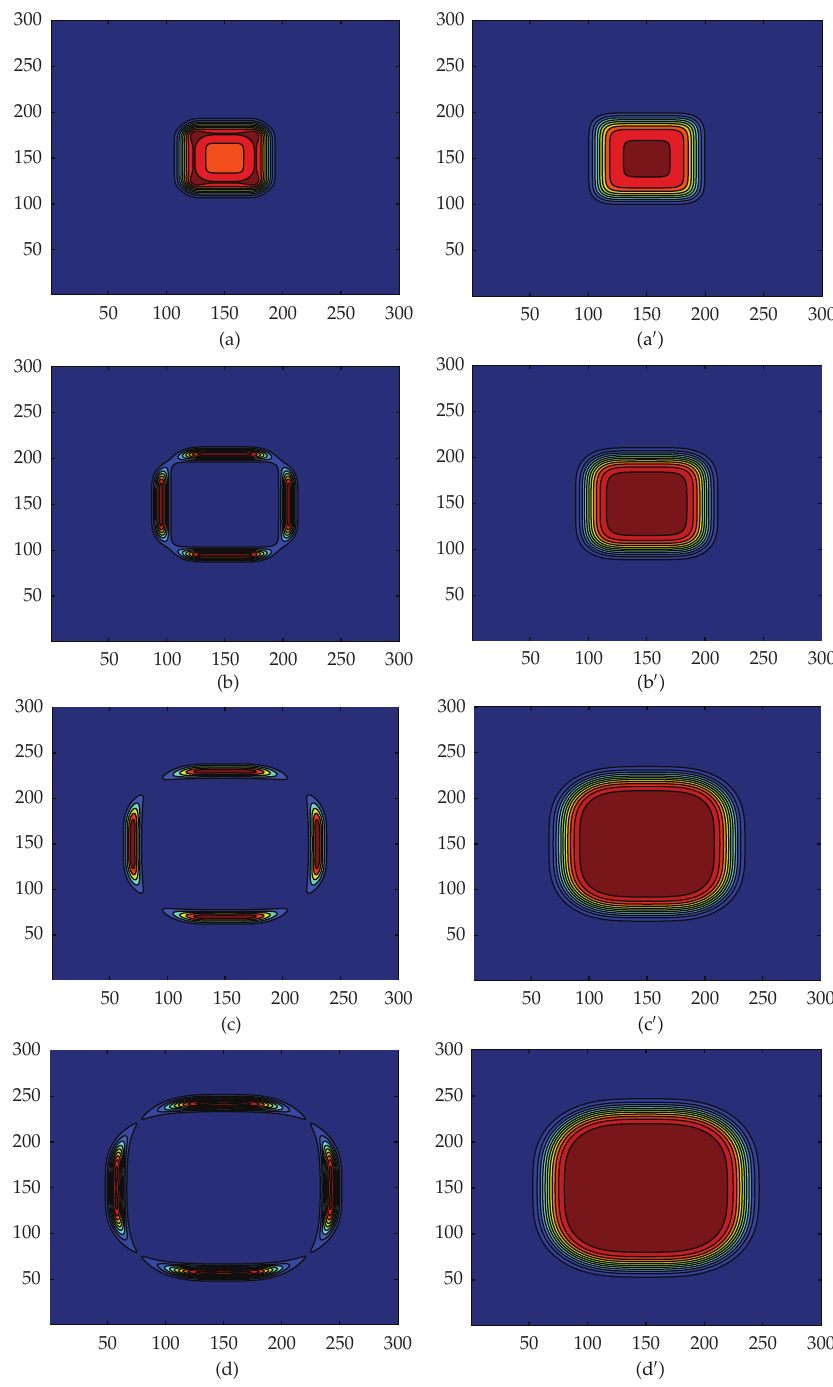
Figure 5: Typical spatial pattern of the density of IGprey (left column) and IGpredator (right column) in two-dimensional space for the system (2a)–(2c). Parameter values: 𝜅 1 = 0.7, 𝜅 2 = 0.4, 𝜅 3 = 0.4, 𝛼 = 2, ℎ = 0.5, 𝑒 1 = 0.1 , 𝑒 2 = 0.21, 𝜀 1 = 1.5 , and 𝜀 2 = 2 . From the top row to bottom, panel represents spatial patterns at time 100, 300, 600, and 1,000,